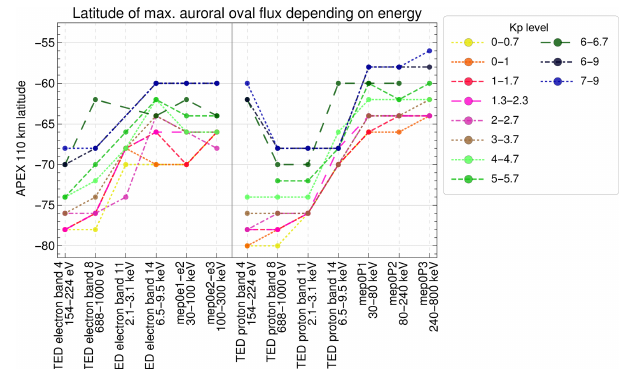
Figure 7. The modified APEX 110km latitude of the maximum flux in the auroral oval is shown. Colours indicate specific Kp levels. The left-hand side displays the energy dependence of electrons, the right-hand side the one of the